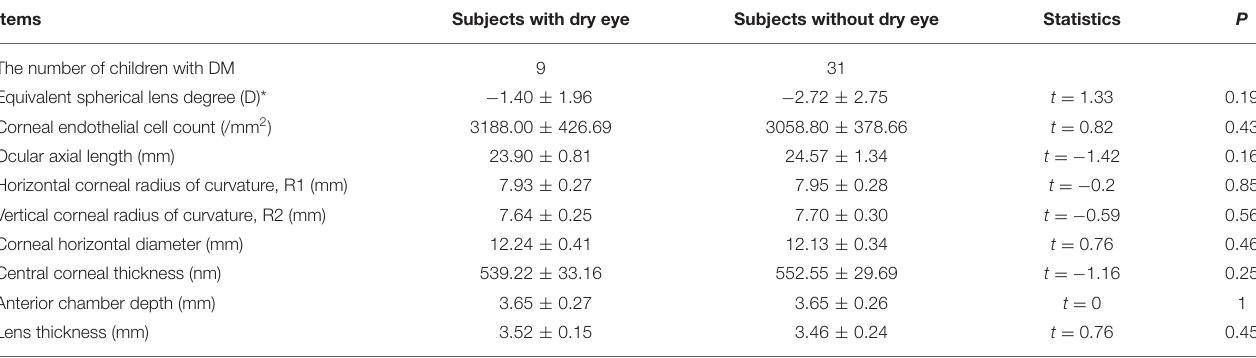
TABLE 3 | Better-seeing Eye examination results of 40 children with DM.